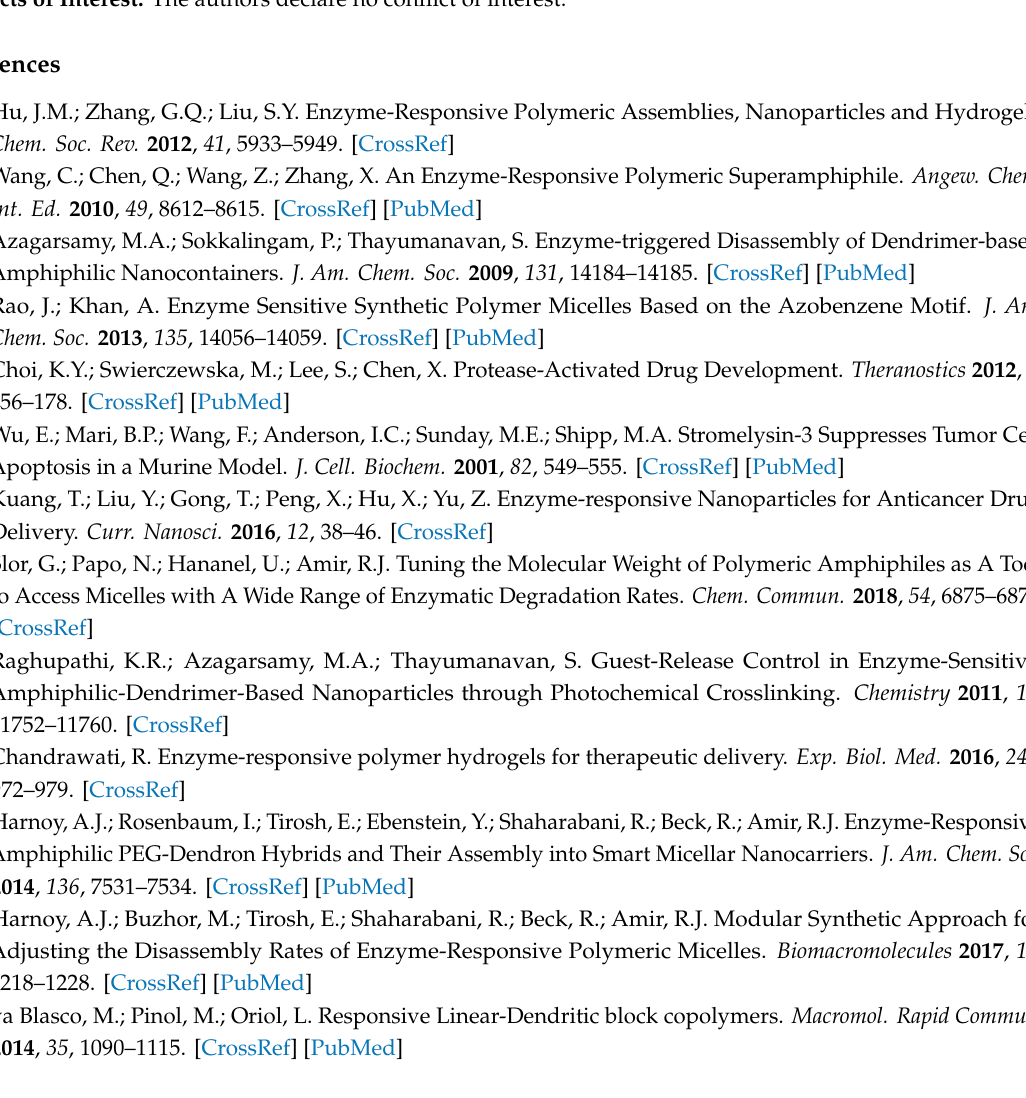
Figure S1: 1 H NMR spectra of PNVP- b - dendr (Phe-Lys) 2 in DMSO-d 6 (a) and D 2 O (b), Figure S2: 1 H NMR spectra of PNVP- b - dendr (Phe-Lys) 3 in DMSO-d 6 (a) and D 2 O (b), Figure S3: Fluorescence spectra of Nile red in phosphate bu ff er solution (pH 7.4) at di ff erent concentrations (a) and ploted of maximum emission intensity versus logarithm of concentration (b) of PNVP- b - dendr (Phe-Lys) 2 , Figure S4: Fluorescence spectra of Nile red in phosphate bu ff er solution (pH 7.4) at di ff erent concentrations (a) and ploted of maximum emission intensity versus logarithm of concentration (b) of PNVP- b - dendr (Phe-Lys) 3 , Figure S5: 1 H NMR spectra in DMSO-d 6 for (Fmoc)Lys(Fmoc)–OH (a), the precipitation of PNVP- b - dendr (Phe-Lys) 3 after the incubation 48 h with trypsin (b) and PNVP- b - dendr (Phe-Lys) 3